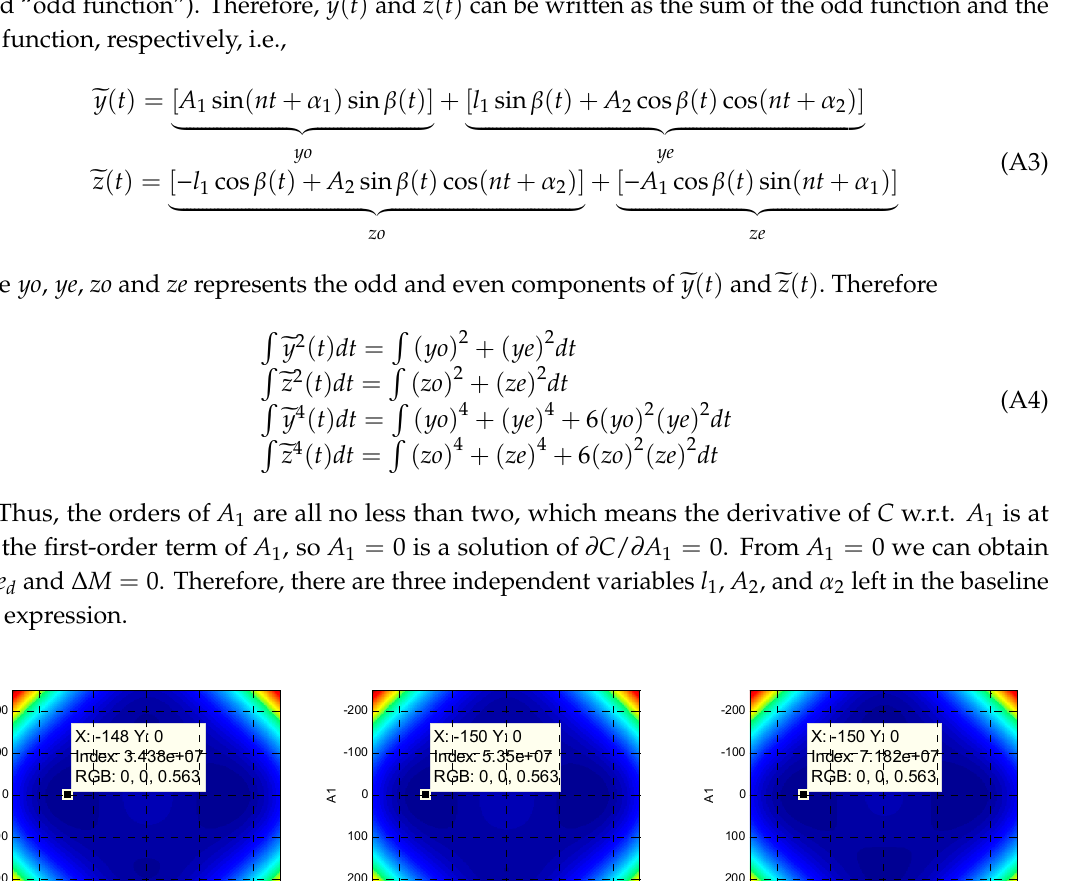
Figure A1. Part of the simulation verification of numerical optimization with fixed α 1 and α 2 . The corresponding parameters are: ( a ) α 1 = 30 ◦ , α 2 = 20 ◦ , i c = 8 ◦ ; ( b ) α 1 = 0 ◦ , α 2 = 90 ◦ , i c = 12 ◦ ; ( c ) α = 90 ◦ , α = 90 ◦ , i c = 16 ◦ . 2 1